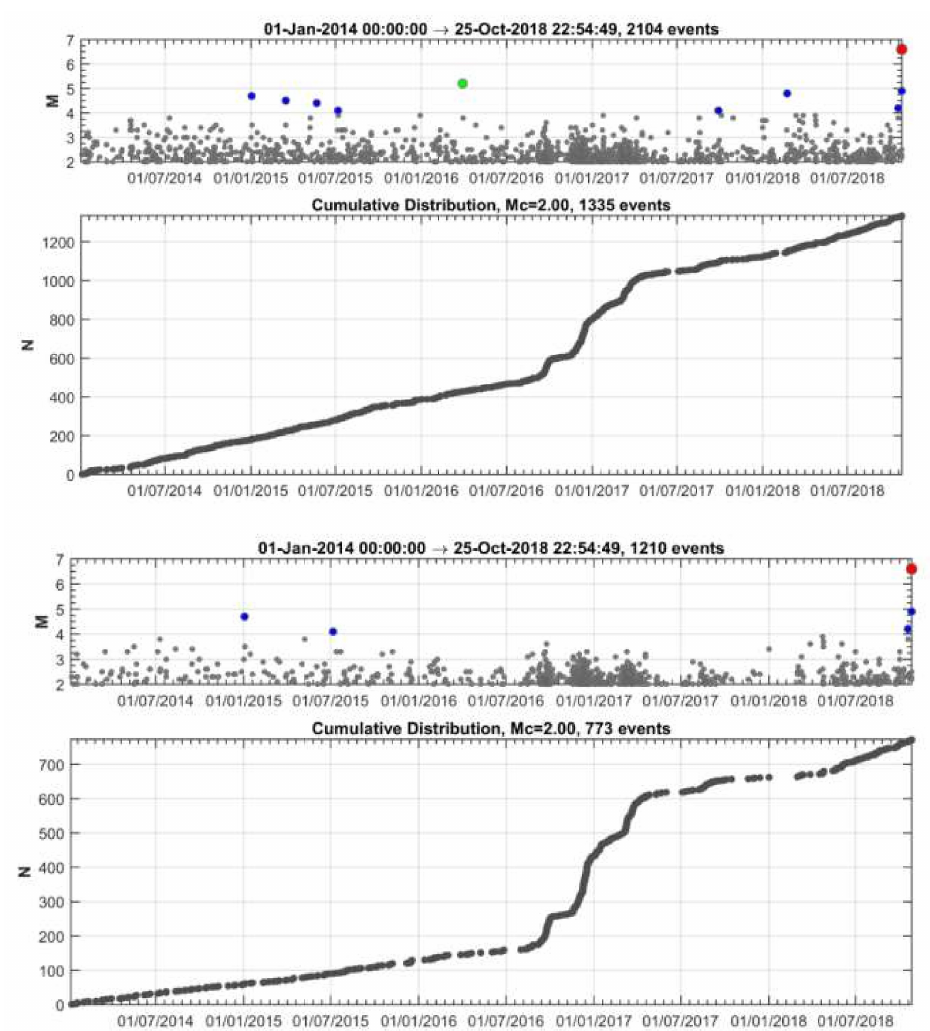
Figure 4. Time distribution of earthquakes listed in NOA catalogue and occurring from 1 January 2014 to the 25 October 2018 mainshock occurrence (red circle) within radii of R = 60 km (upper panel) and R = 30 km (lower panel) from the mainshock epicenter. In each panel all the catalogued events as well as the cumulative number, N, of only events of M c ≥ 2.0 are plotted. N versus time shows four seismicity stages: (1) 1 January 2014–1 August 2016 (background seismicity BGS 1), (2) 1 August 2016–1 May 2017 (cluster1), (3)1May2017–20April2018(backgroundseismicityBGS2), (4)20April2018–25 October 2018 (cluster 2). Colored dots shows earthquake size as in Figure 3. Only earthquakes of M L < 4 occurred during the cluster 1 (swarm). Two imminent foreshocks (M w = 4.1, M w = 4.8, Figure 1b) occurred during the foreshock sequence (cluster